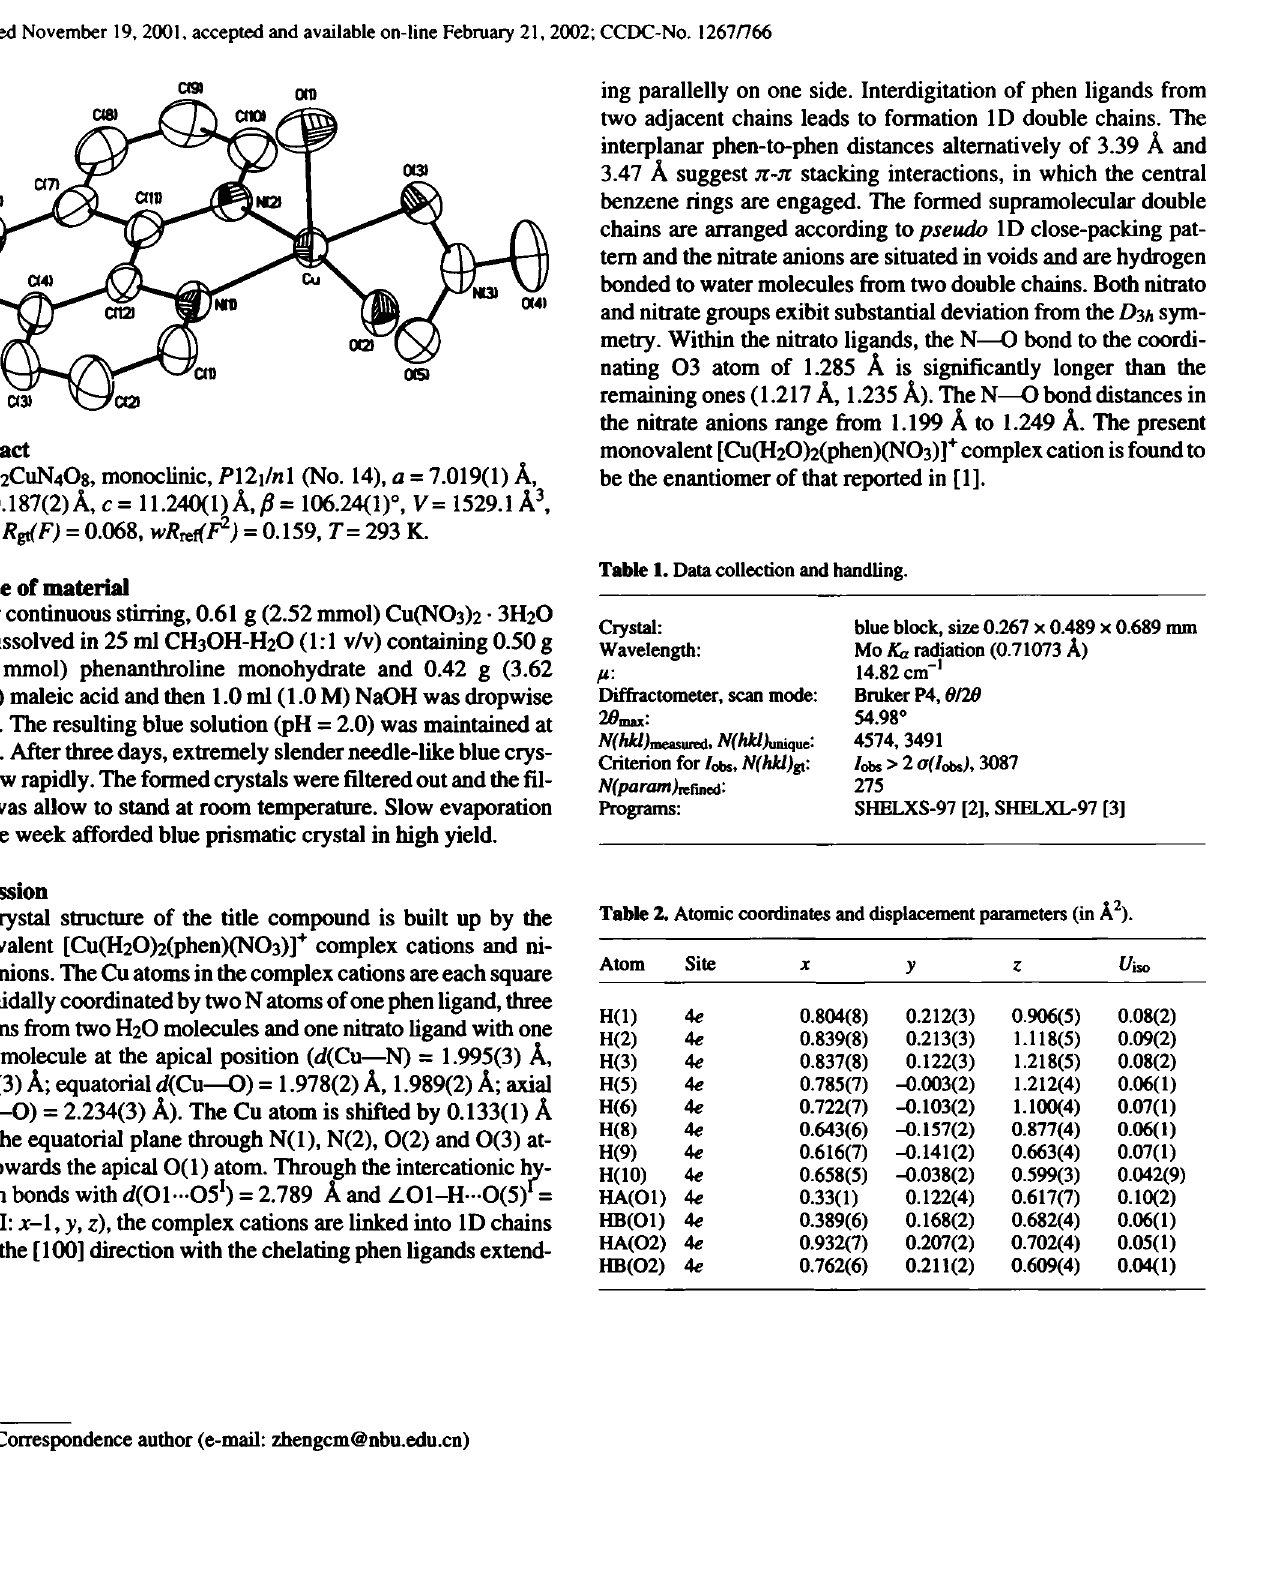
Table 2. Atomic coordinates and displacement parameters (in Â 2